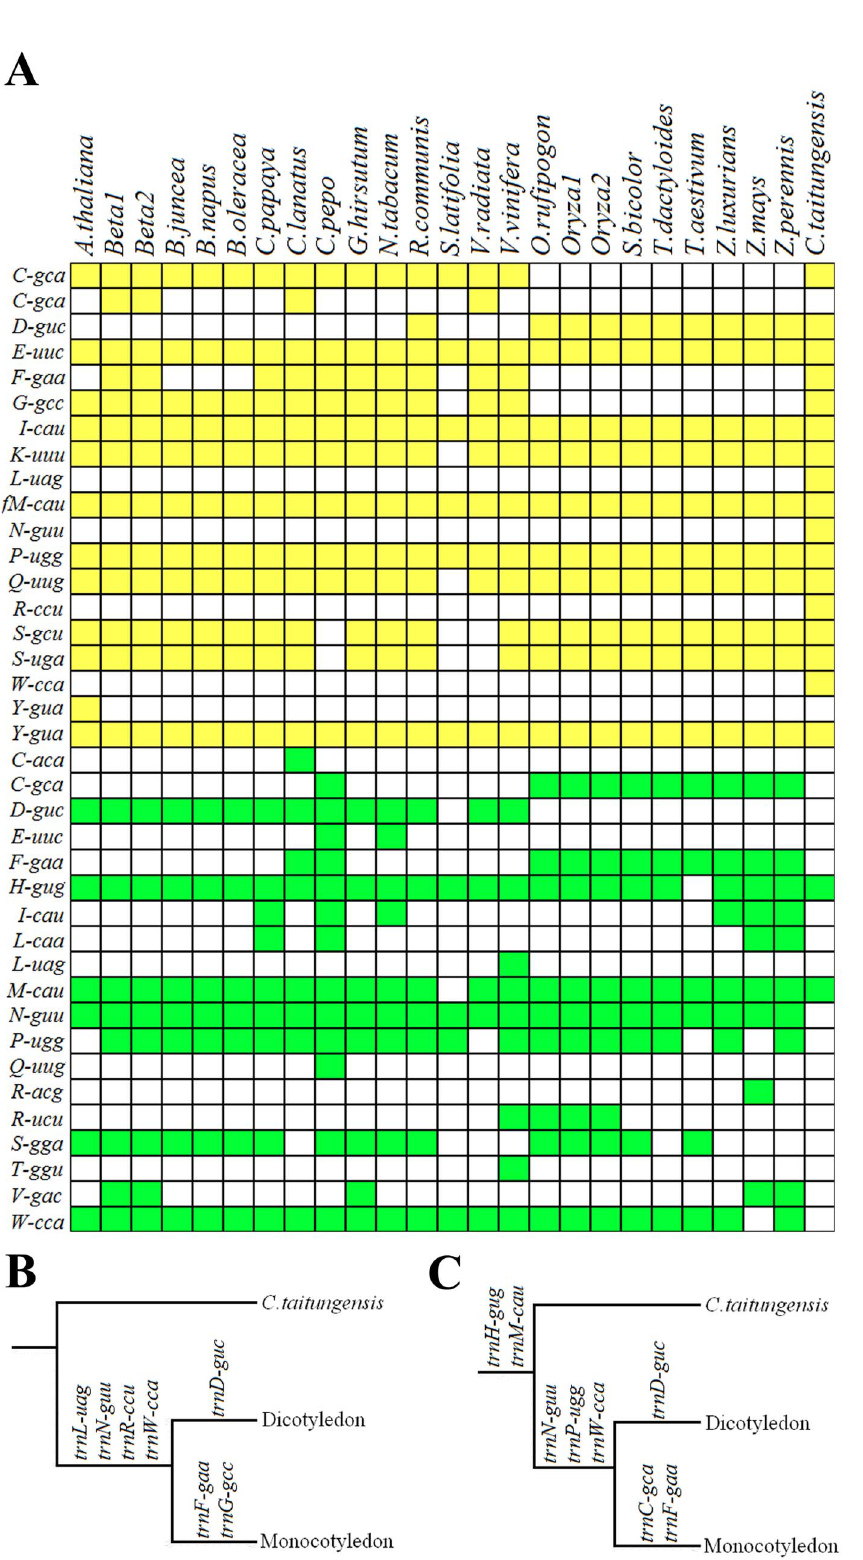
PLOS ONE | www.plosone.org